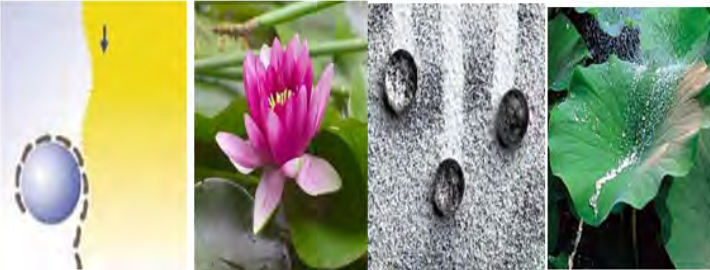
Figure 5. Human designer copying nature using the idea of the Lotus flower cleaning itself despite being in a swamp. Source: (Feuerstein,